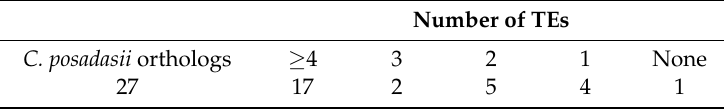
Table 3. C . posadasii orthologous protein-encoding loci associated TEs. Table 3. C. posadasii orthologous protein-encoding loci associated TEs. Number of TEs Number of TEs